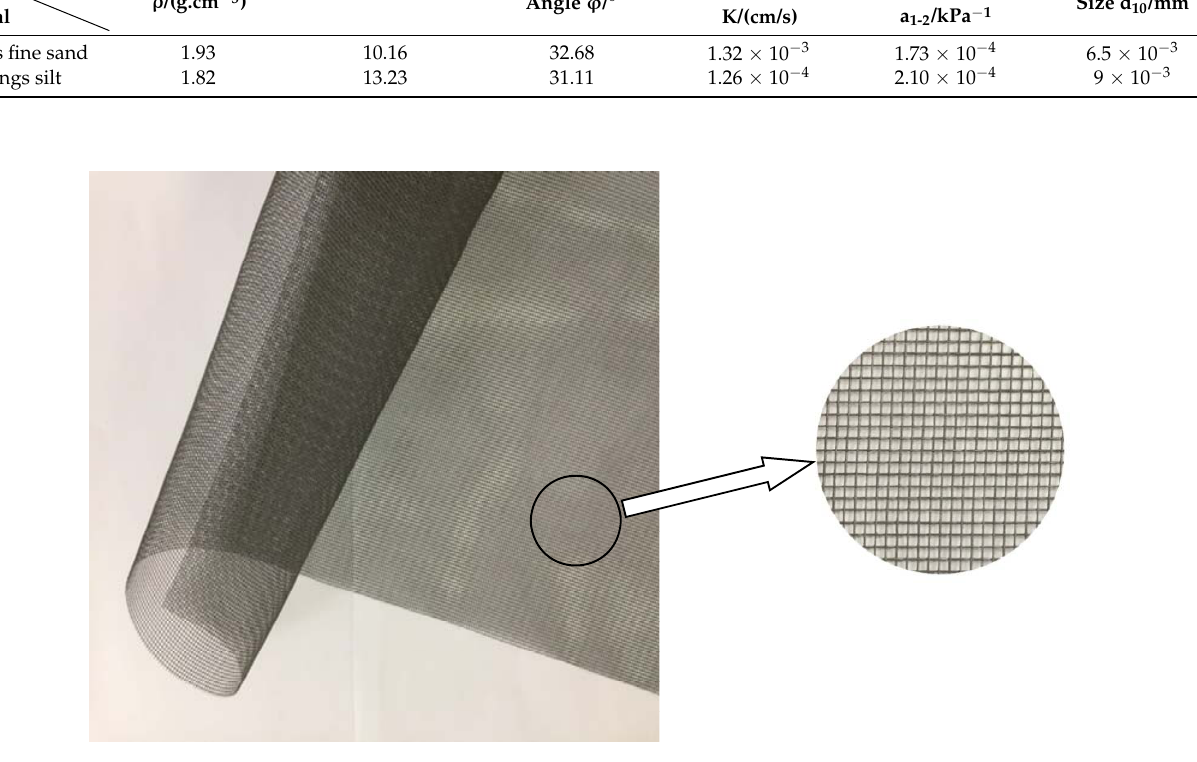
Table 2. Strength indexes of unidirectional glass fiber.